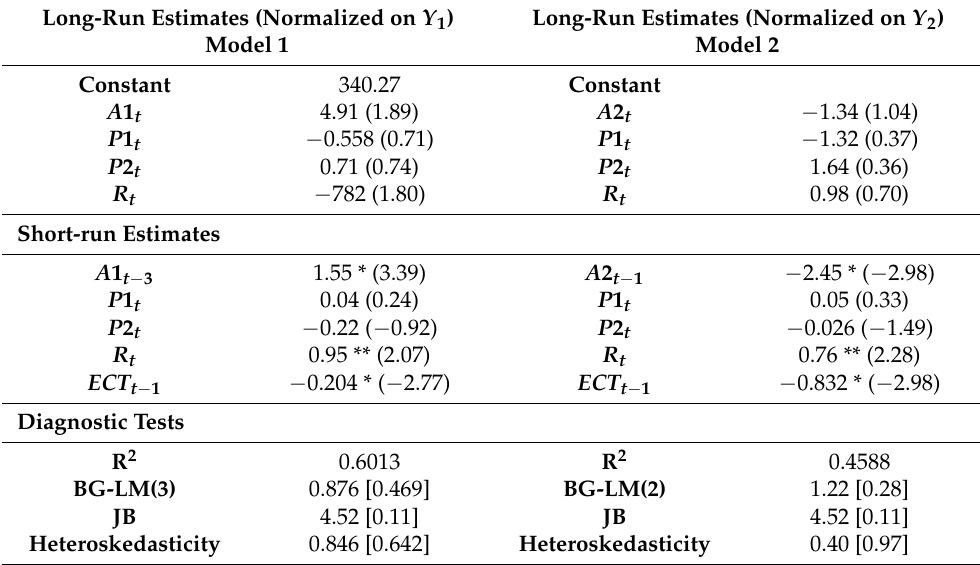
Table 7. Long- and short-run